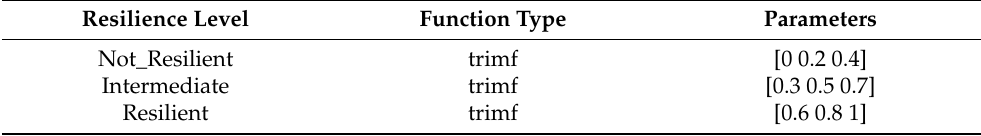
Table 4. Resilience level membership functions with three terms.